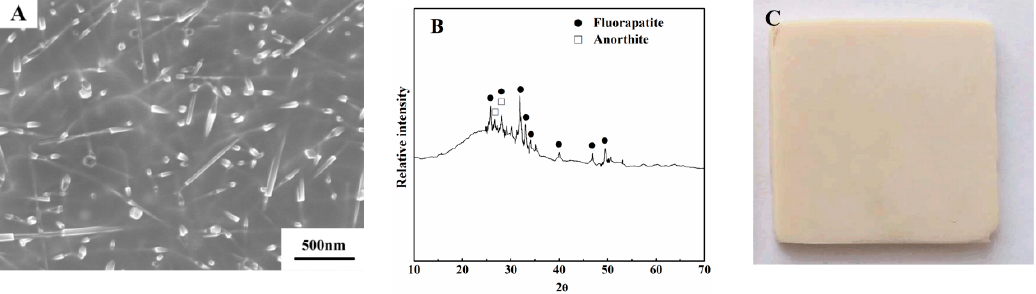
Figure 1. ( A ) Microstructure, ( B ) XRD patterns, and ( C ) the appearance of the fluorapatite glass-ceramic. This figure has been modified from previous publications with permission from the publishers [24].